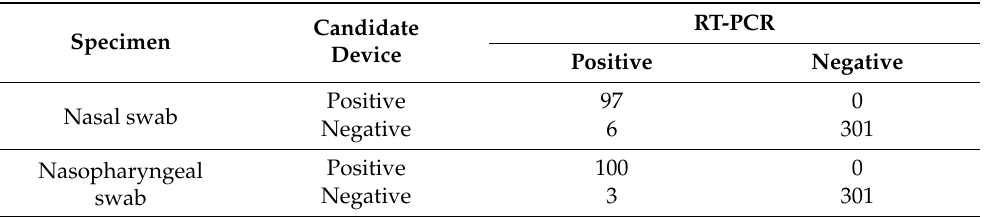
Table 3. GenBody COVID-19 Ag test results compared to reference method in nasal and nasopharyn- geal samples.